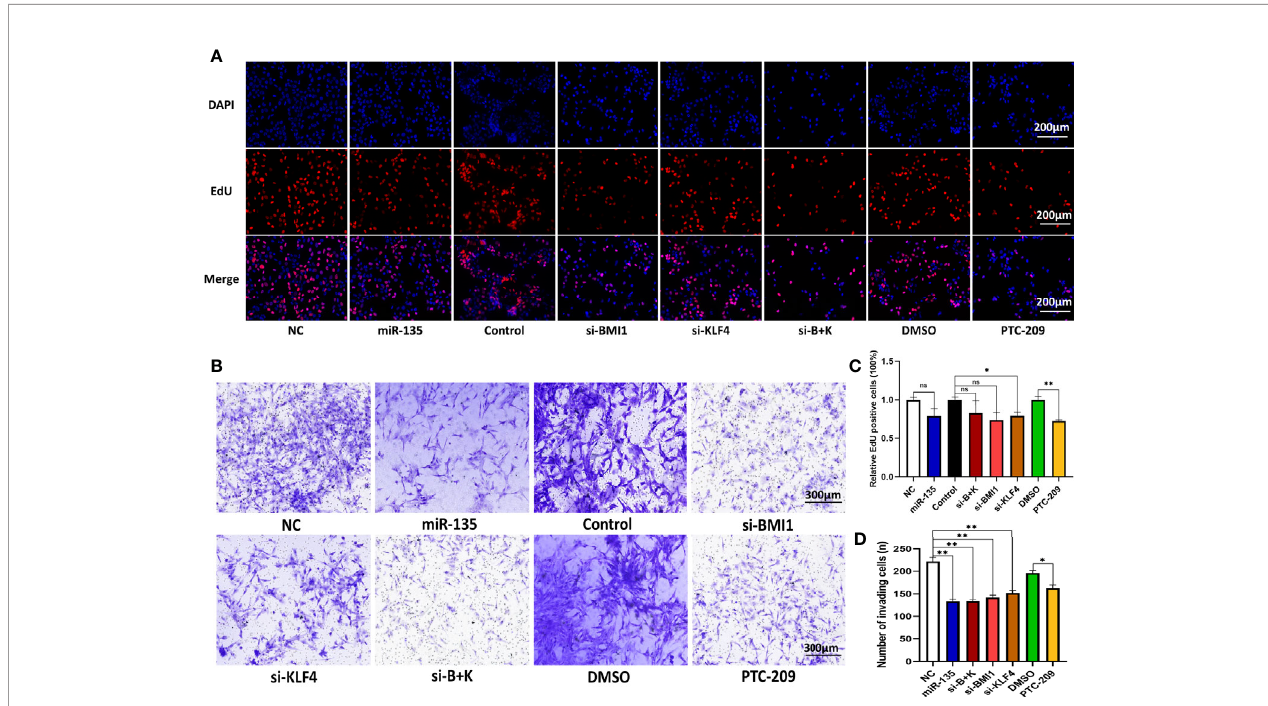
FIGURE 2 | Downregulating of KLF4 and using PTC-209 suppress the OS cell proliferation; miR-135a, si-BMI1, si-KLF4, combination therapy, and PTC-209 suppress the OS cell invasion. (A) Representative pictures from tumor cell EdU assay. Saos-2 cells were grown and transfected with Lv-miR-135a or negative controls, si-BMI1/KLF4 or their control, and treatment with PTC-209 or DMSO, and then subjected to the EdU assay. Scale bar, 200 m m. (B) Representative pictures from transwell invasion assay. The Saos-2 cells with same treatments as above were subjected to the transwell assay. Scale bar, 300 m m. (C) The graph is the quanti fi ed data of the EdU assay (ns p > 0.05; * p < 0.05; **P < 0.01; n = 3). (D) The graph is the quanti fi ed data of the transwell invasion assay (* p < 0.05; ** p < 0.01; n = 3). The data were expressed as the mean ± SEM. NC (Lentivirus negative control), miR-135 (Lentivirus overexpressed miR-135a), Control (siRNA negative control), si-BMI1 (group interfered with siRNA-BMI1), KLF4 (group interfered with siRNA-KLF4), si-B+K (group interfered with siRNA-BMI1 and siRNA-KLF4). ns, not signi fi